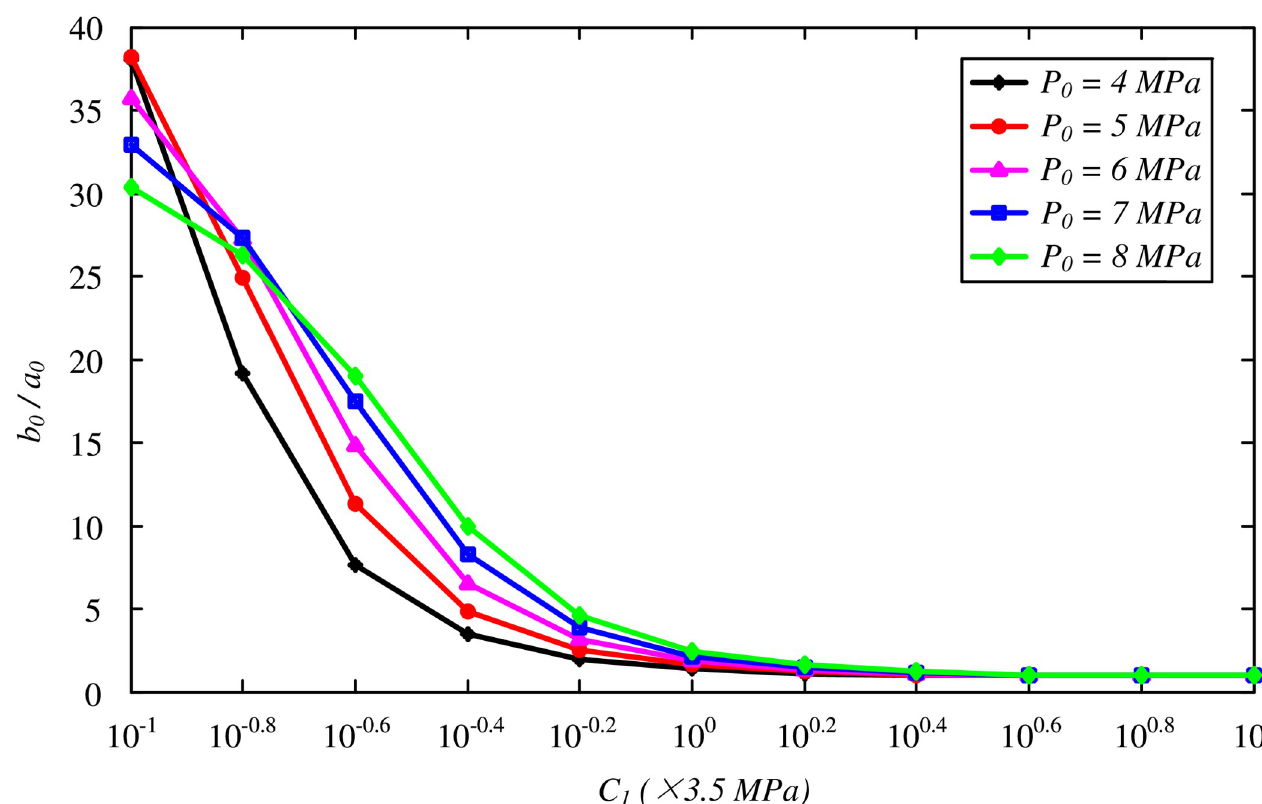
Fig 7. Variation of optimal thickness of the FSW with cohesion C 1